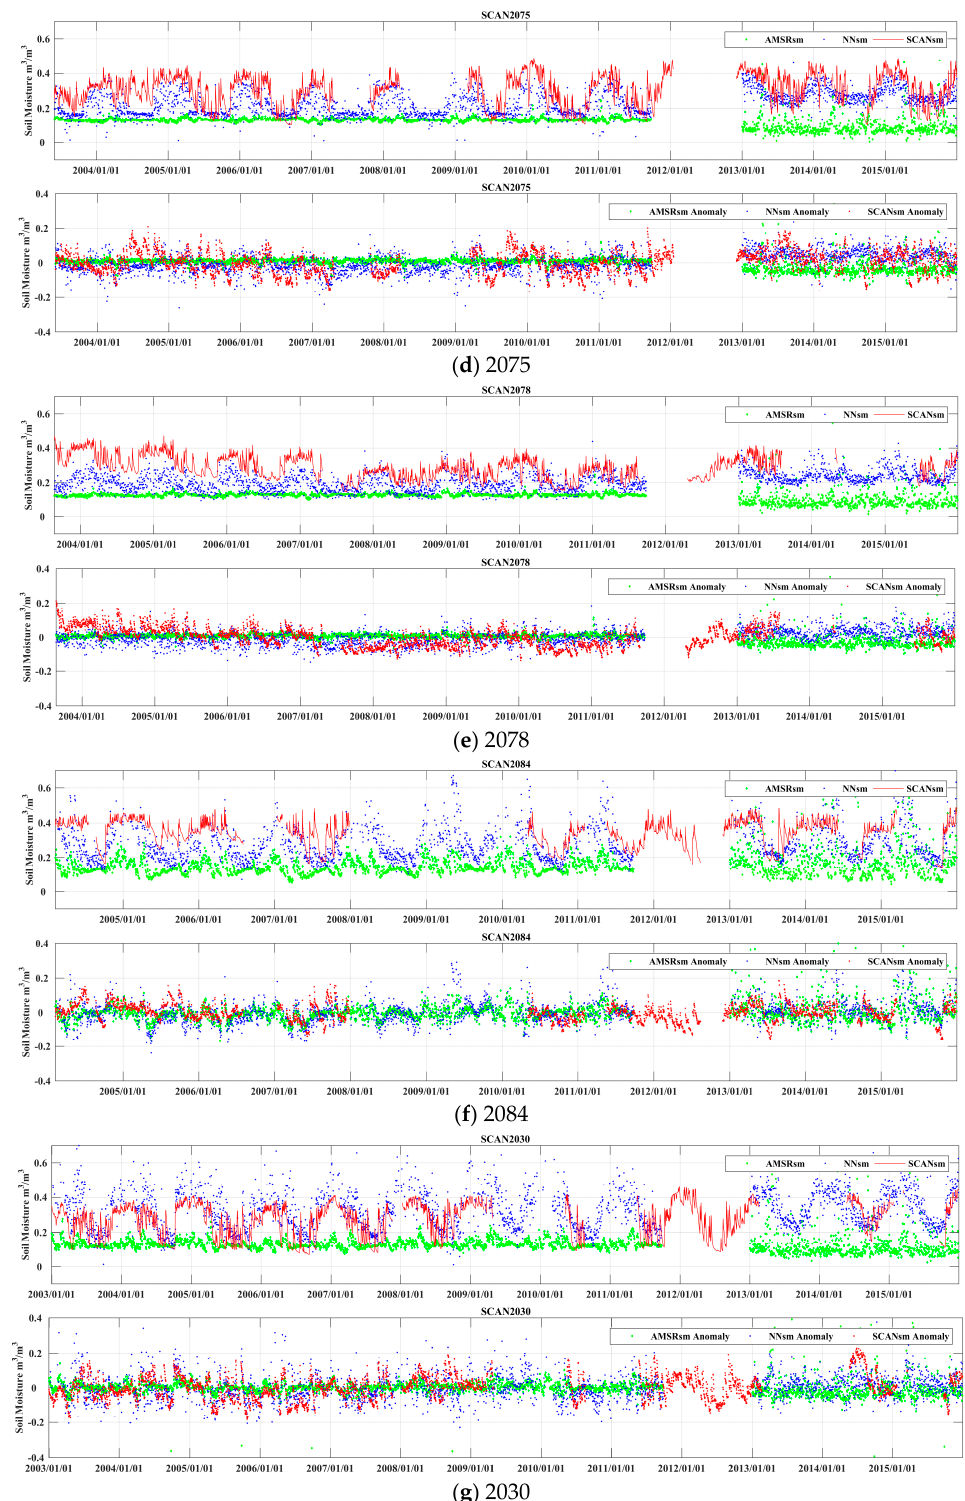
Figure 6. Time series (upper panel) and anomaly time series (lower panel) for SCANsm (red line), NNsm (blue dots) and AMSRsm (green diamonds) over the long time period (2003–2015) in sites: ( a )